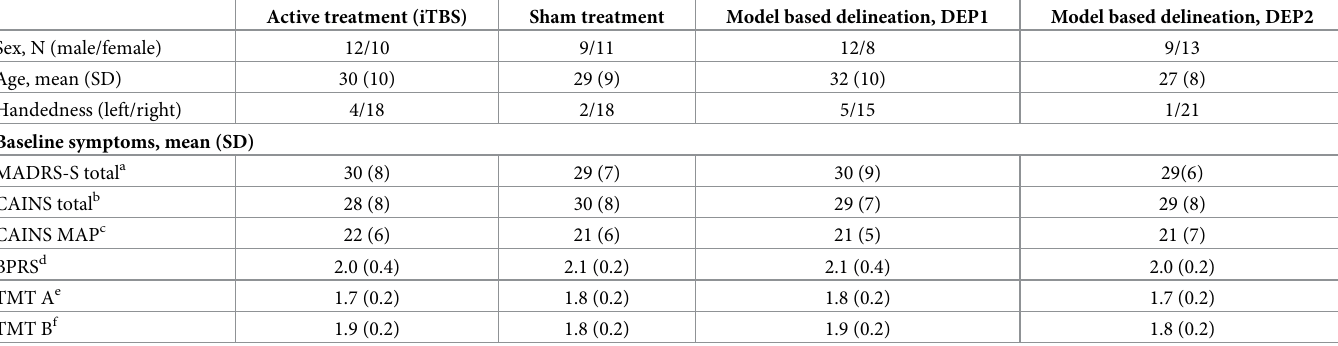
Table 1. Demographics and baseline clinical data. Active treatment